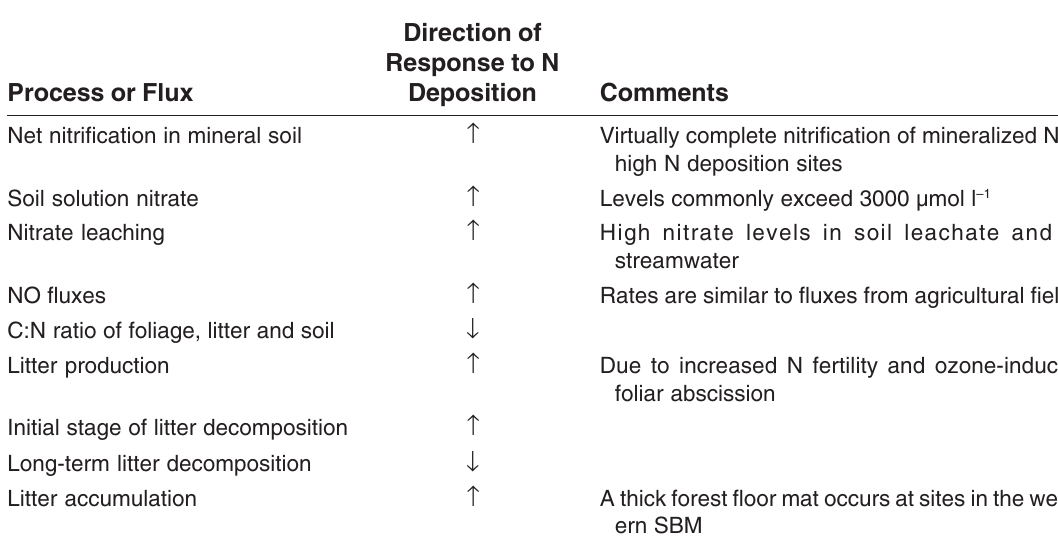
Nutrient Fluxes and Pools that are Affected